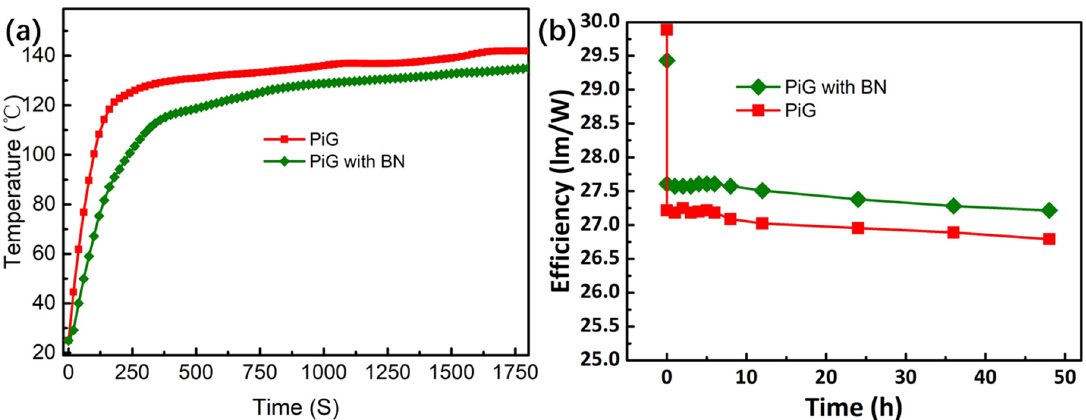
Figure 12. The working-temperature curves ( a ) and luminous e ffi ciency variation ( b ) of LED lamps made of PiG and PiG with BN.